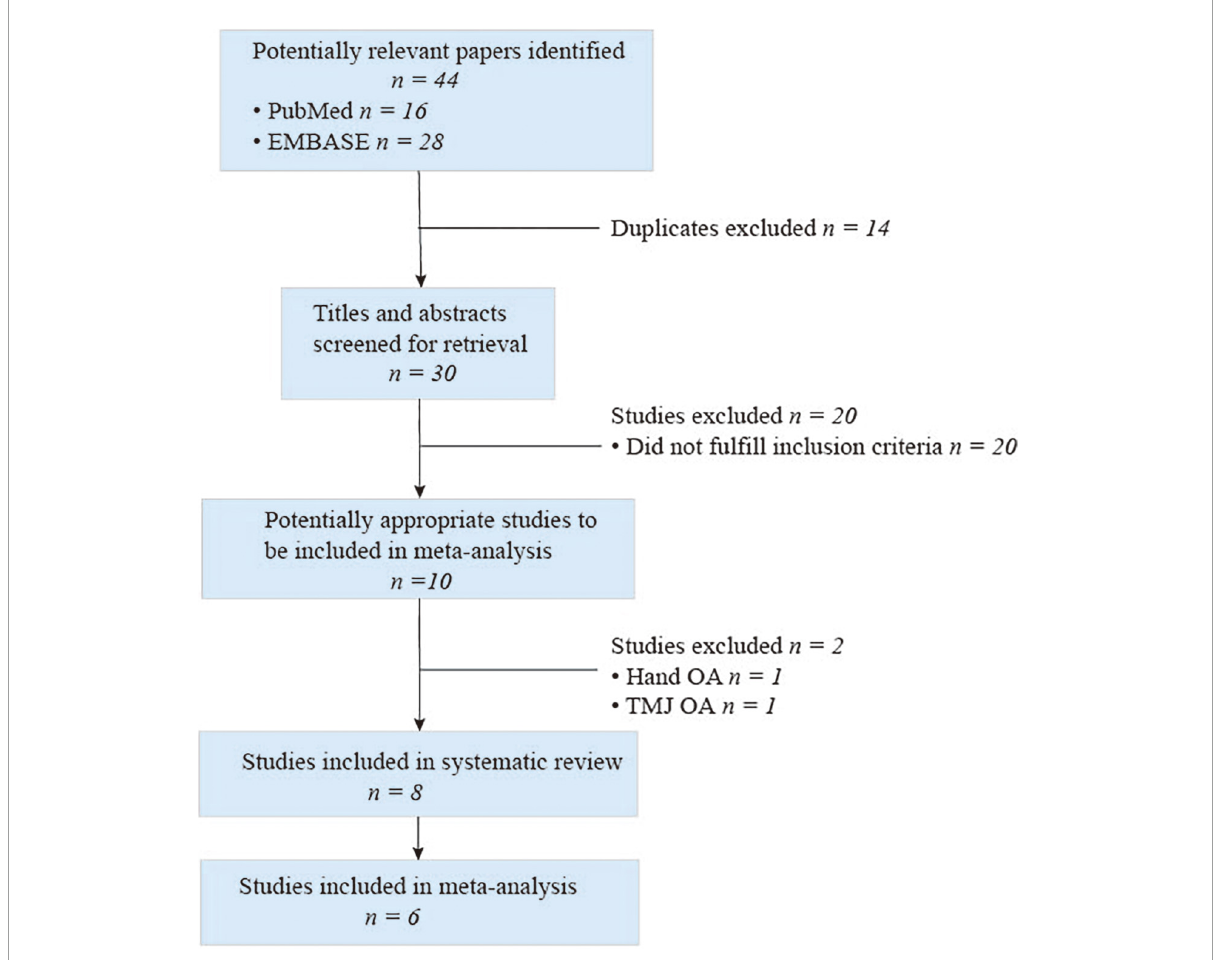
FIGURE2 Selection for eligible citations included in this systematic review and